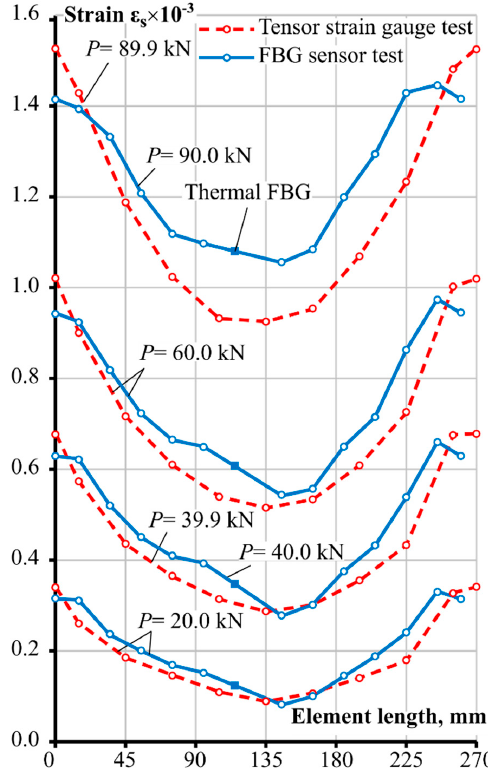
Figure 4. Experimental reinforcement strain distributions along the steel bars at key loadings steps.